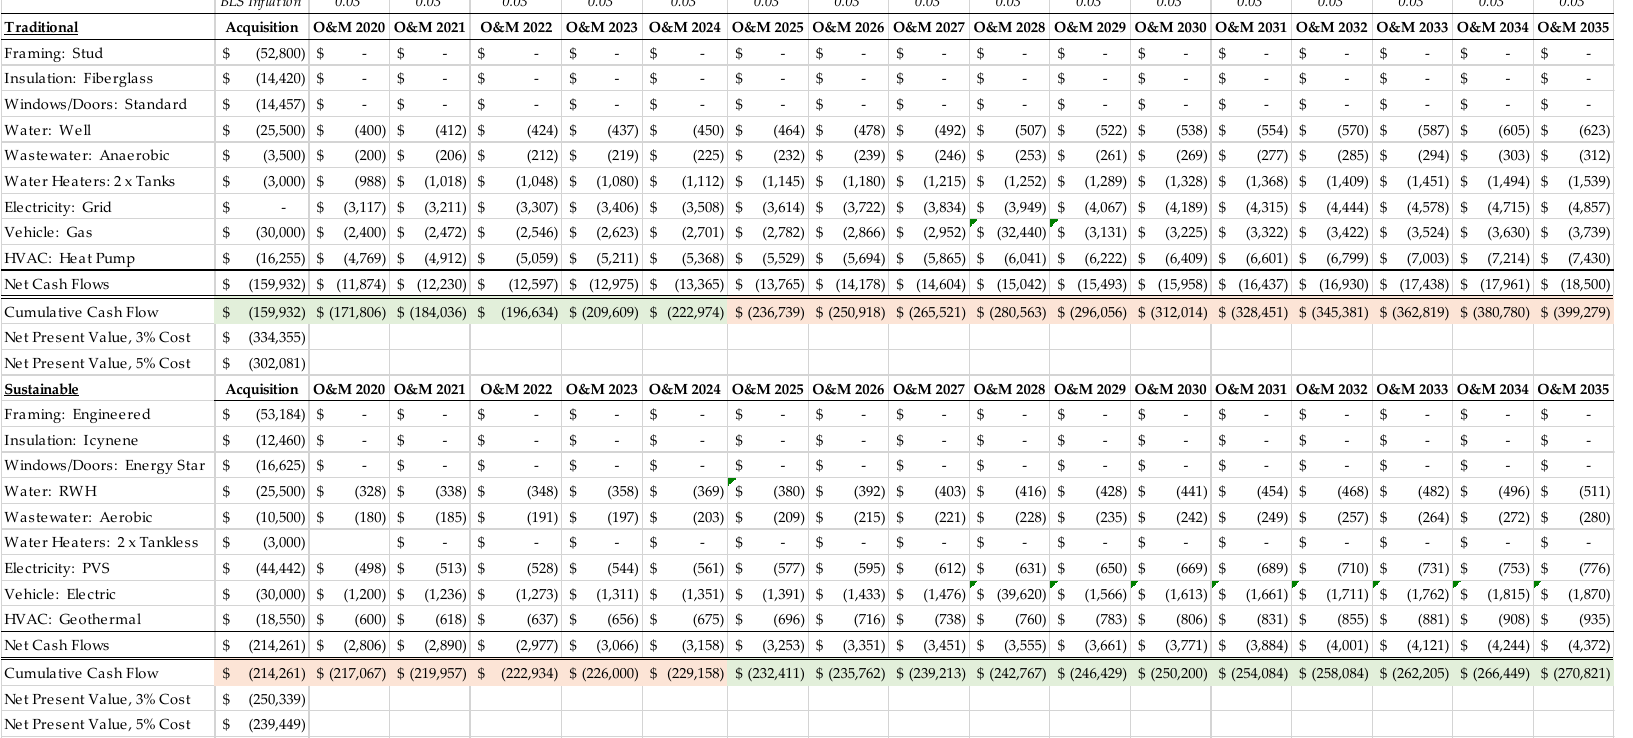
Figure 6. Color-coded break-even and NPV analysis.